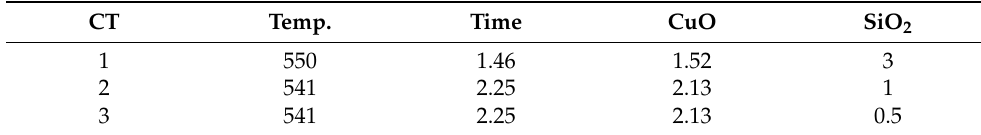
Table 12. The results obtained from the random forest and RSM tested on the confirmation test.